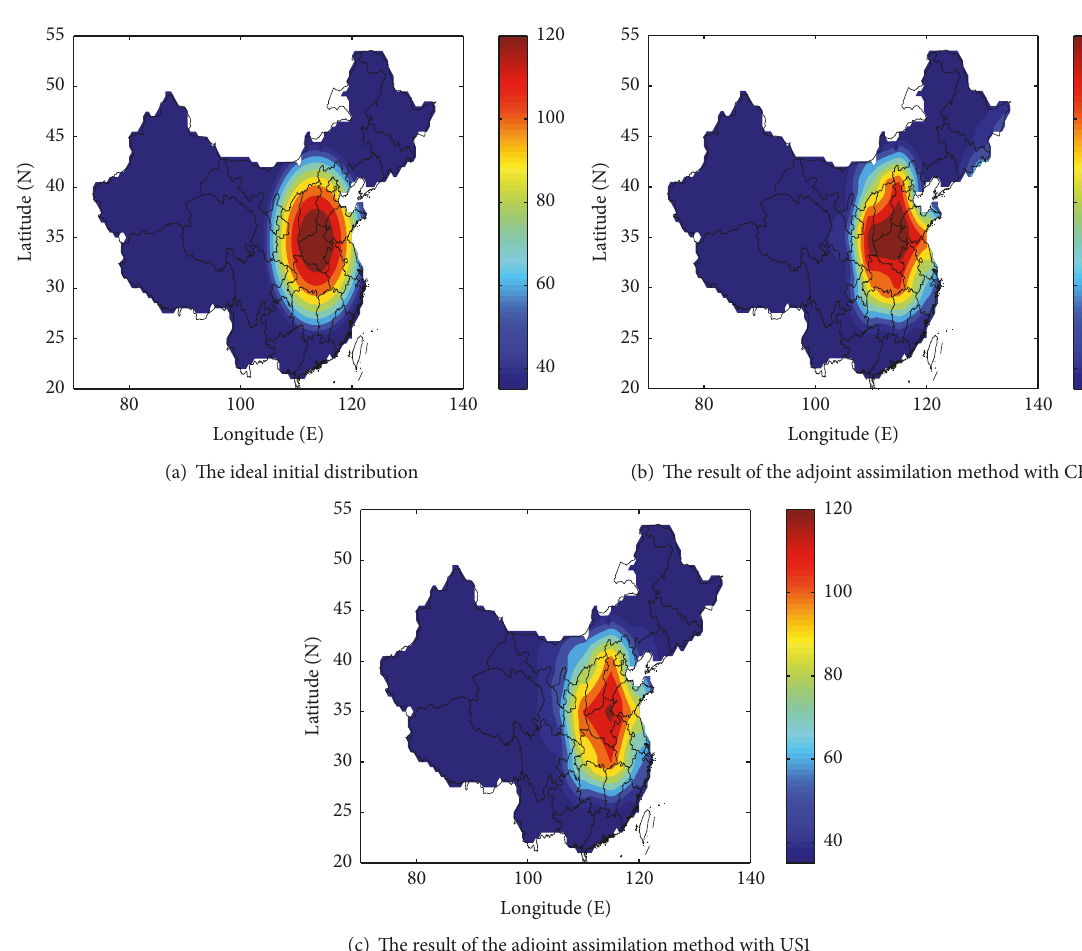
Figure 4: The 2D images of the results inverted by the adjoint assimilation method with different schemes.